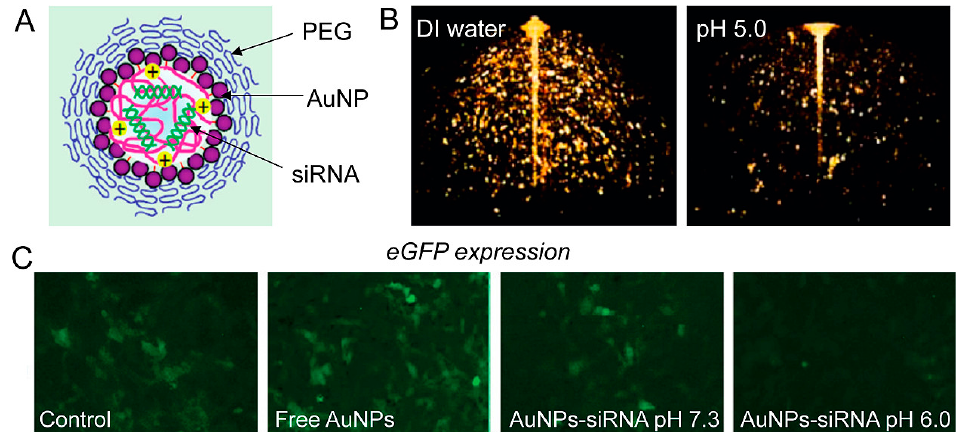
Figure 6. ( A ) AuNPs in imaging and gene-silencing NP design. The siRNA payload is released when the nanoparticle is hydrolyzed at a low pH. ( B ) Three-dimensional optical coherence tomography pictures of AuNP-based nanoparticles (the lower intensity image on the right confirms NPs’ disintegration at lower pH). ( C ) When eGFP-expressing NIH 3T3 cells are treated with AuNPs–siRNA at low pH, fluorescence microscopy demonstrates gene silencing (reprinted with permission from